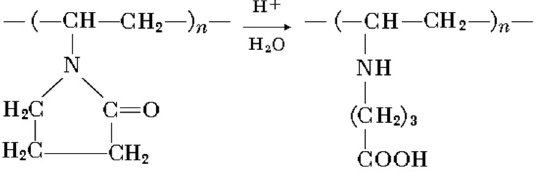
Figure 9. IR spectra of the (a) PVP–CAY and (b) PVP–MAY powders.